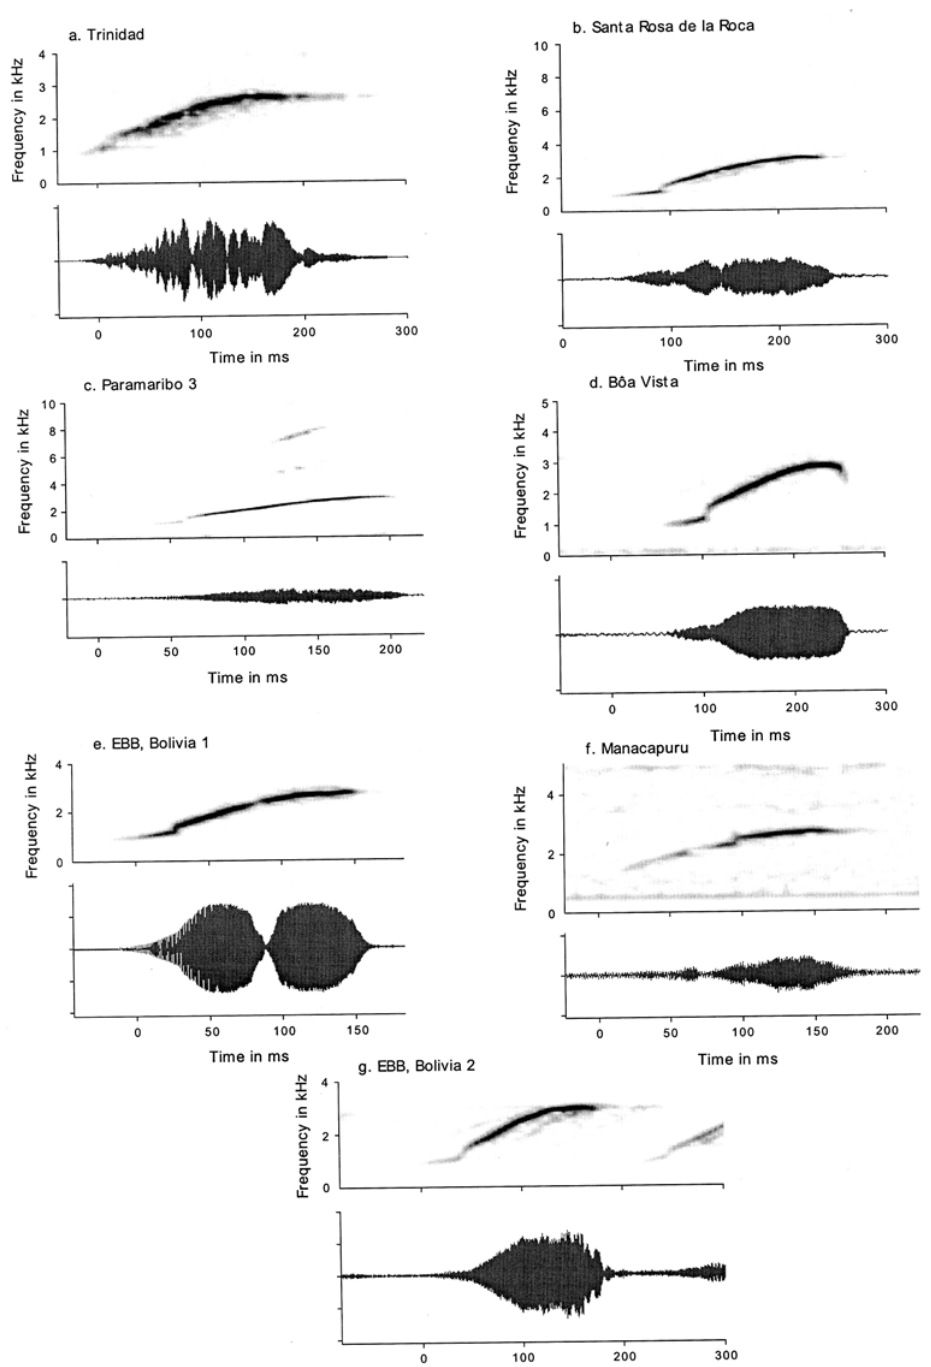
Fig. 2 – Audiospectrogram and wave form of the advertisement call of Leptodactylus fuscus from (a) Trinidad, (b) Santa Rosa de la Roca, Bolivia, (c) Paramaribo, Suriname, recording of frog 3, (d) BoaVista, Brazil, (e) Estación Biologica del Beni, Bolivia, S. Reichle recording of frog 1, (f) Manacapuru, Brazil, (g) Estación Biologica del Beni, S. Reichle recording of frog 2.